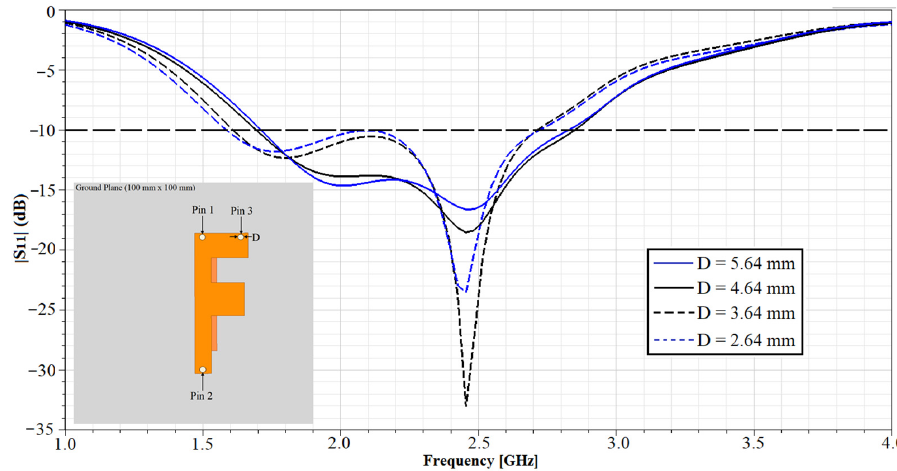
Figure 9. Variation of reflection coefficient |S 11 | with respect to the diameter (D) of the shorting pins.